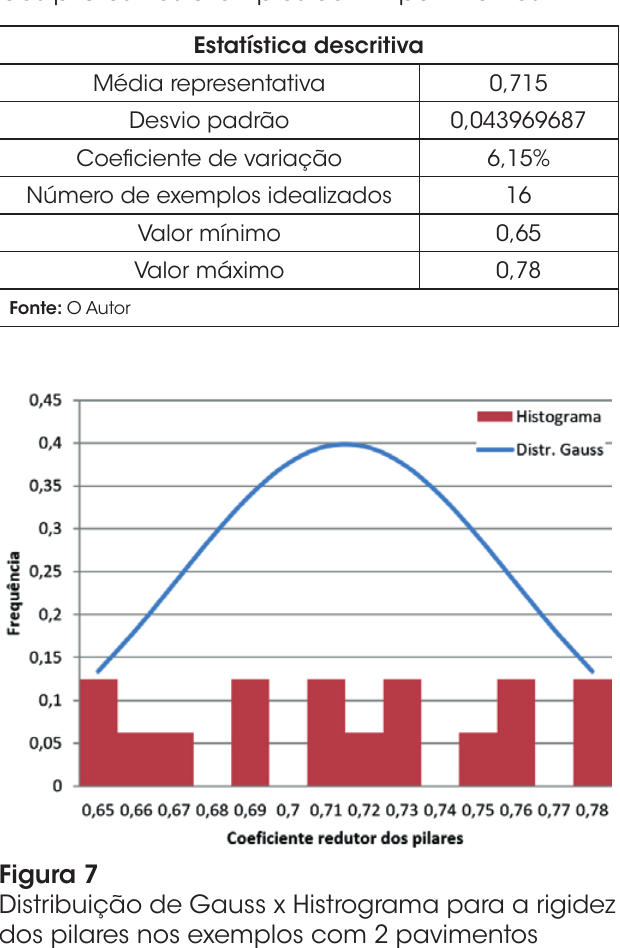
Na figura 6, pode-se visualizar o gráfico de distribuição de Gauss x Histograma e, na tabela 9, estão dispostos os valores da média representativa, desvio padrão, coeficiente de variação e valores de máximo e mínimo.